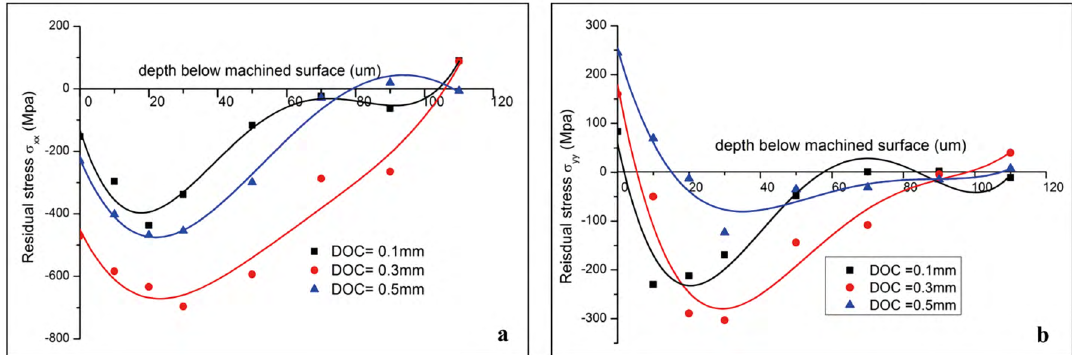
, (b) σ , ( a =0.2mm, V =60m/min, f =0.06mm/rev, lead angle=10°, tilt angle=0°, xx yy e eff